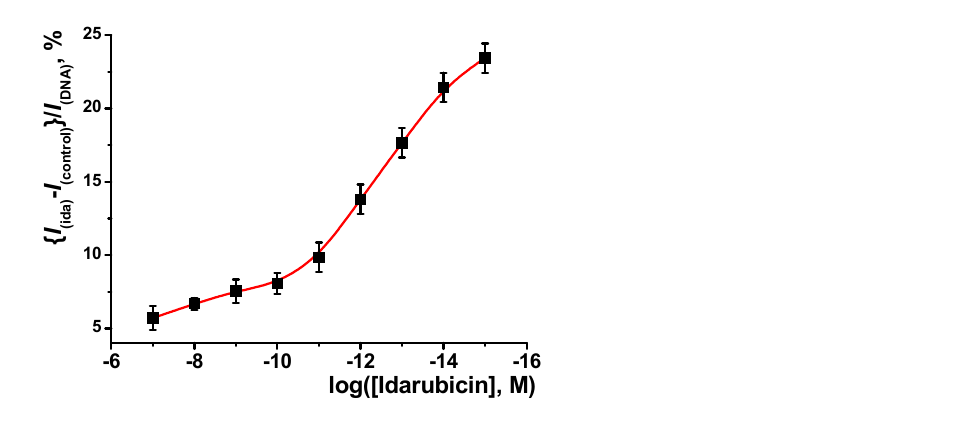
Figure 9. Calibration curve for idarubicin determination on PAB-2/DNA-MB. Cyclic voltammetry, 0.1 M HEPES buffer containing 0.03 M NaCl, pH 7.0.